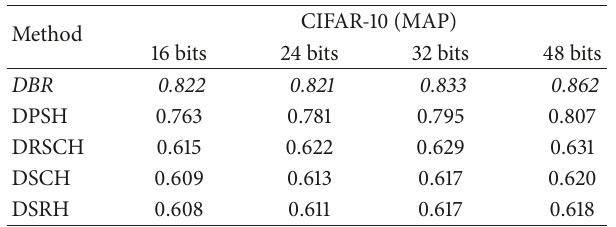
Table 5: MAP of image retrieval on CIFAR-10 dataset with 4 different bit lengths. We use 10000 query images and calculate the MAP within top 50000 returned